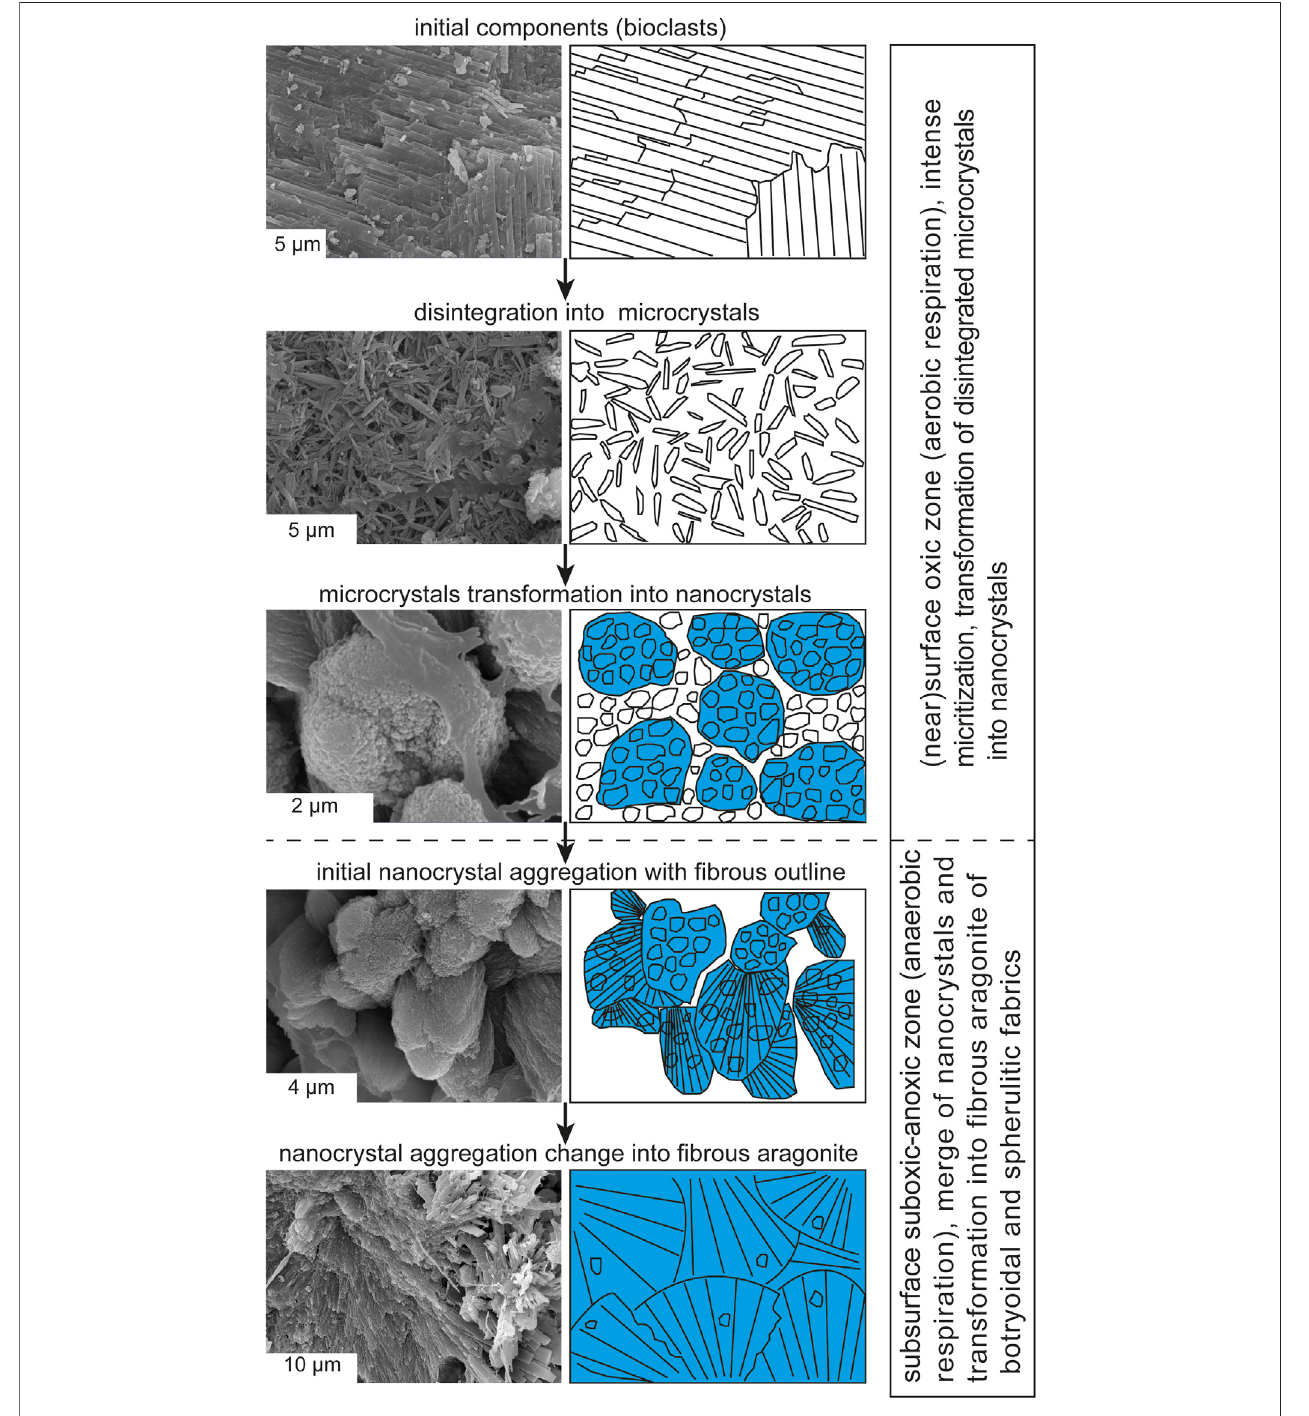
FIGURE 8 | A sketch showing the fabric transformation from primary bioclasts, then to peloids, and fi nally to botryoids at Abu Dhabi. The change from bioclasts to peloids is via grain disintegration related to endolithic microorganisms; and the replacement of peloids by botryoids is via micritic and fi brous recrystallization. During the replacement process, there are three main steps: i) intense micritization leads to disintegration of bioclasts into microcrystalline debris; ii) transformation of the microcrystalline debris into nanocrystal aggregation. iii) transformation of nanocrystal aggregation into fi brous aragonite of botryoidal and spherulitic fabrics.